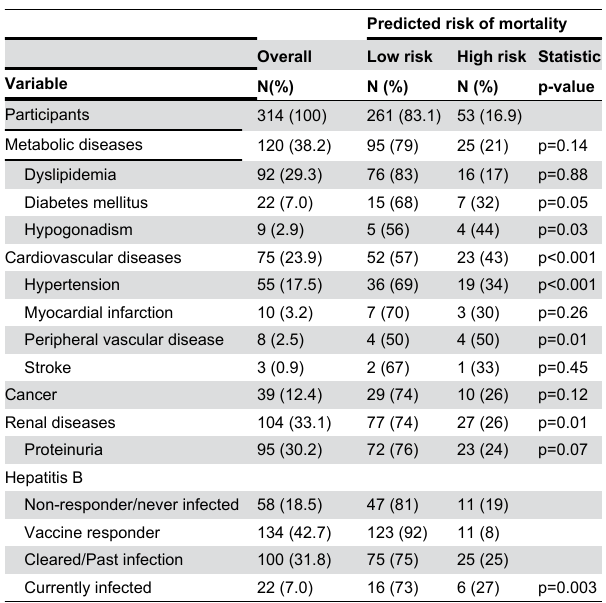
Table 2. Prevalence of medical comorbidities not included in the VACS index across total cohort and as per predicted high and low risk 5 year mortality as estimated by VACS